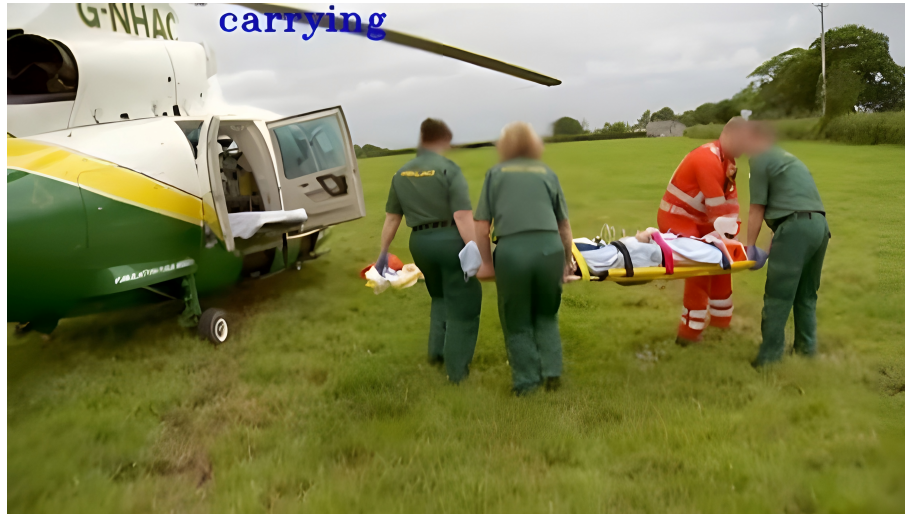
Figure 13. Carrying recognition results in a simpler background.